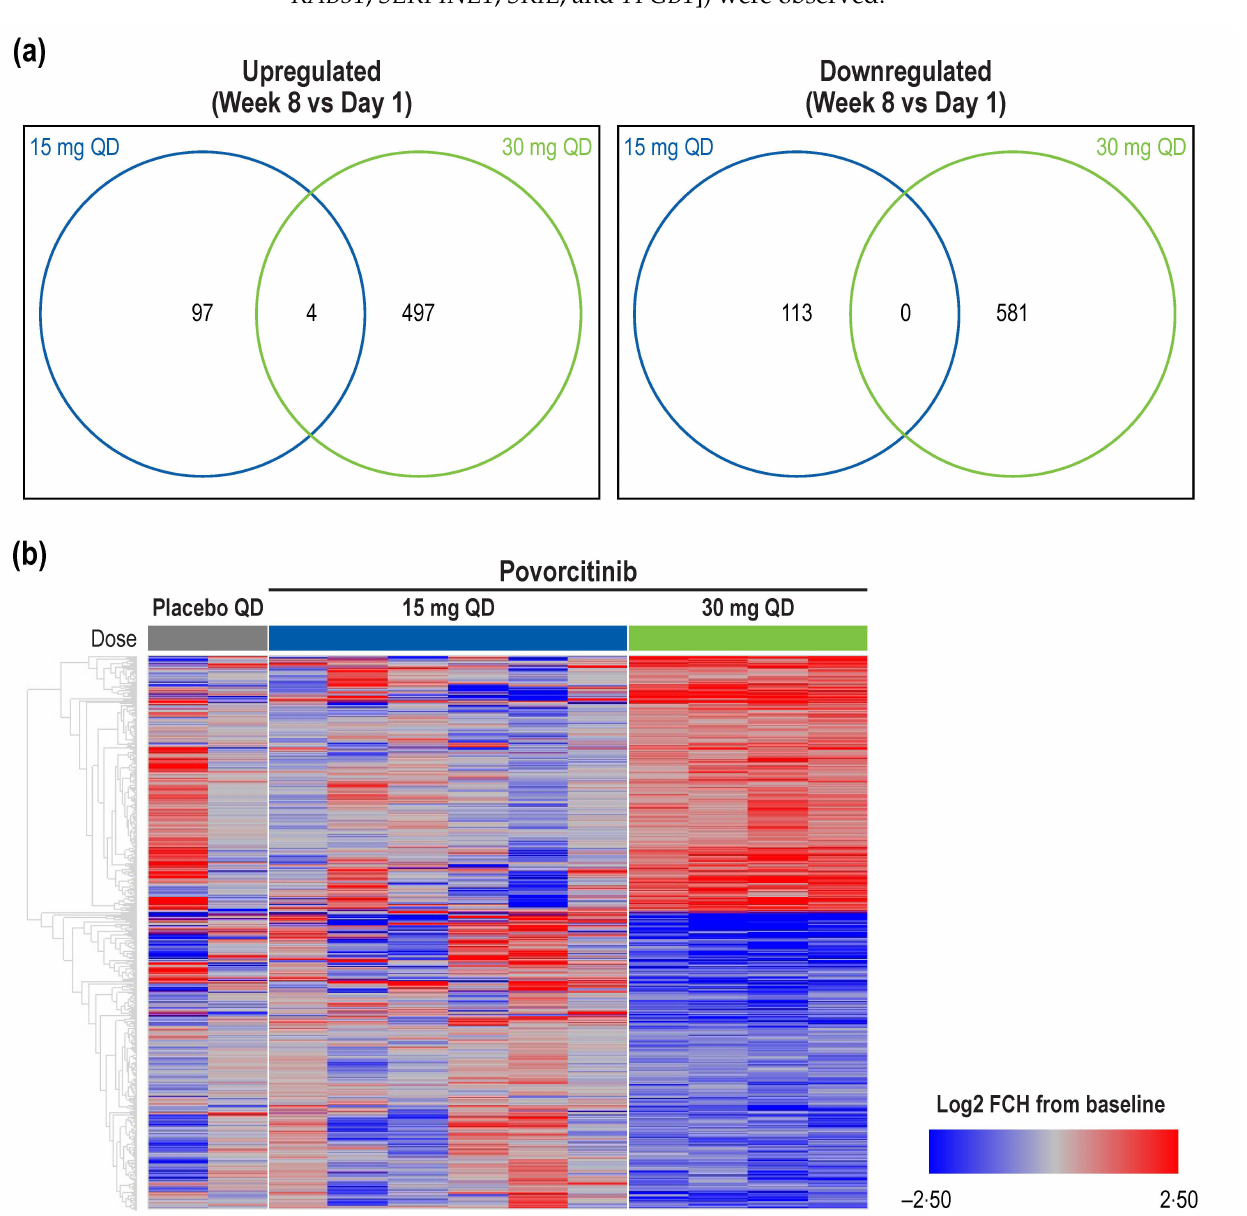
Figure 1. Differential gene expression following treatment with povorcitinib. ( a ) Overlap between 15 and 30 mg povorcitinib QD for DEGs in HS lesional skin biopsies from Week 8 vs. baseline. ( b ) Heatmap of treatment-mediated gene expression change in lesional HS skin biopsies between Week 8 and baseline. DEG, differentially expressed gene; |FCH|, absolute fold change; HS, hidradeni- tis suppurativa; QD, once daily. The cutoff for significance was p < 0.05 and |FCH|